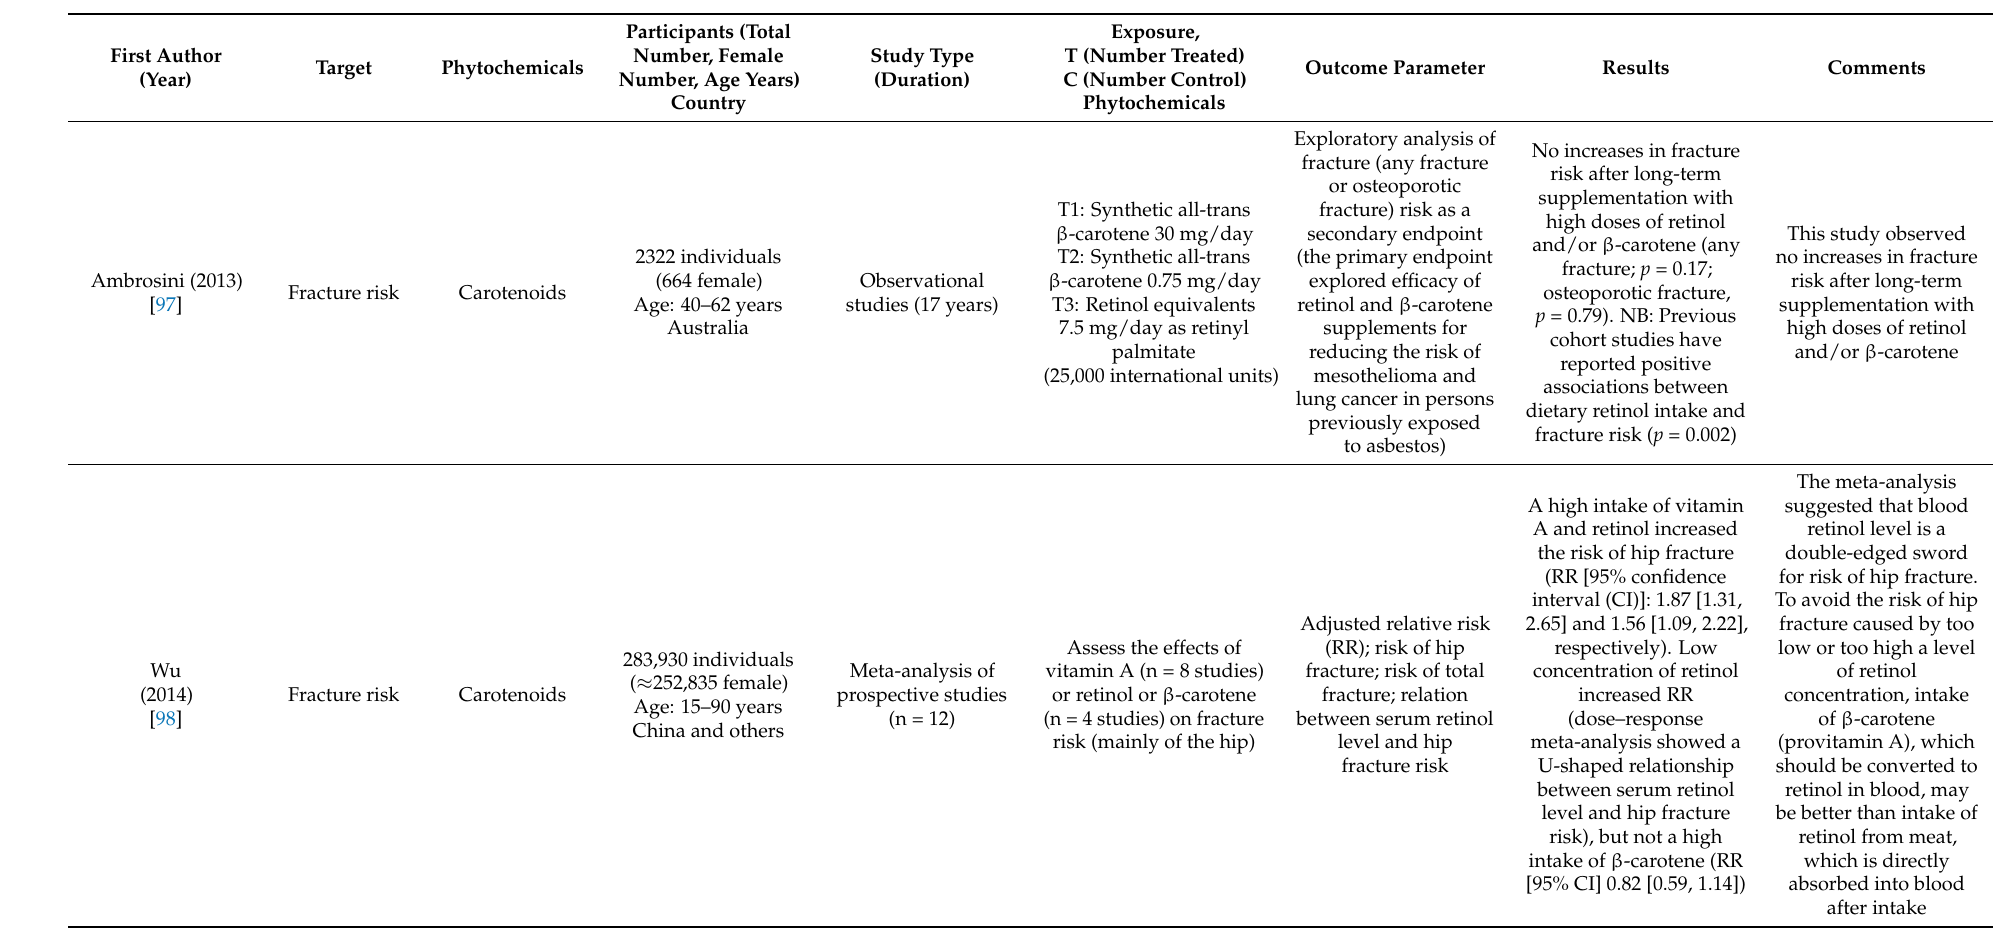
Table 6. Summary of selected studies regarding the therapeutic area of bones and